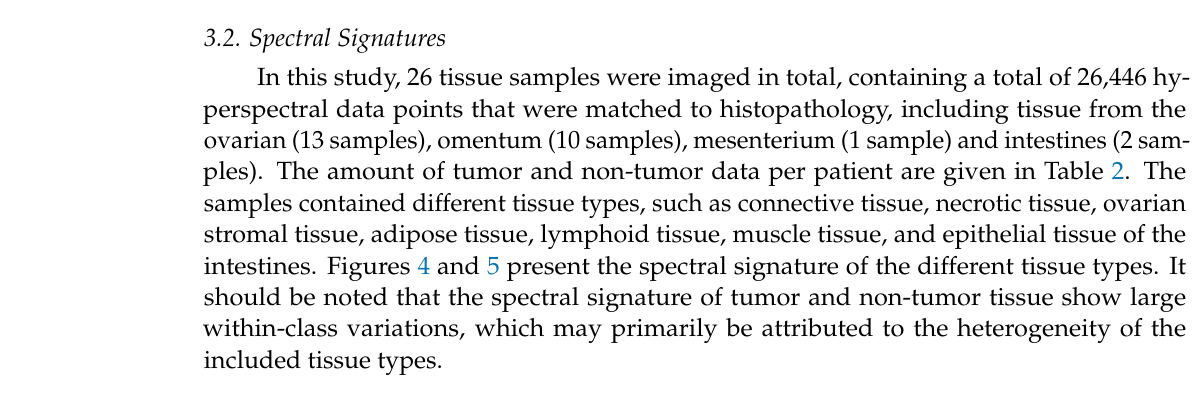
Table 2. Amount of tumor and non-tumor data points per